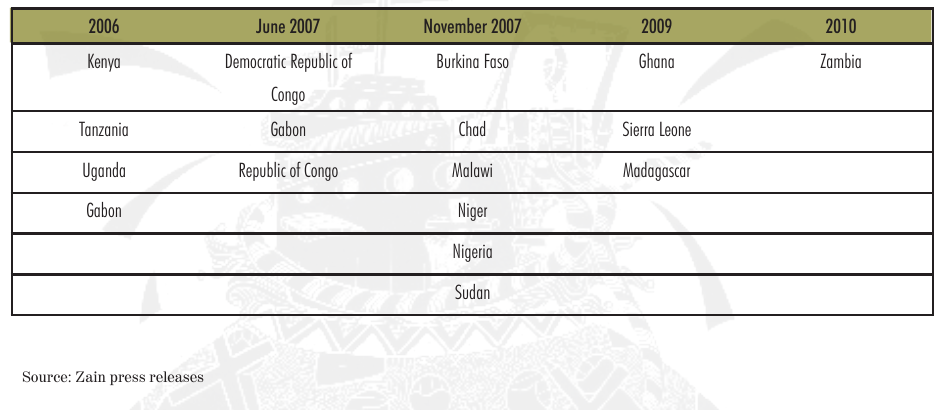
THE GROWTH OF THE ZAIN ONE NETWORK